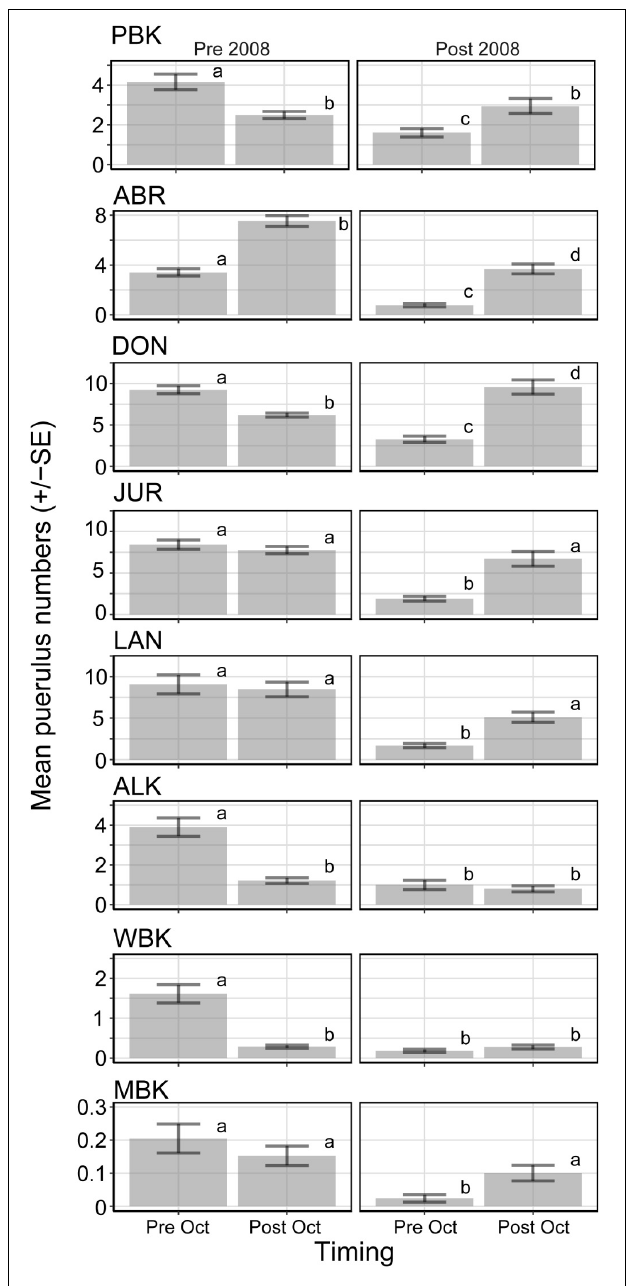
FIGURE 5 | Mean puerulus numbers in the early (May—October) and late (November—April) half of the seasons before (pre 2007) and after (post 2009) the low settlement period. The interaction between site, timing and before or after the decline was significant in the ANOVA model. Results of pair-wise comparisons are indicated by alphabetic